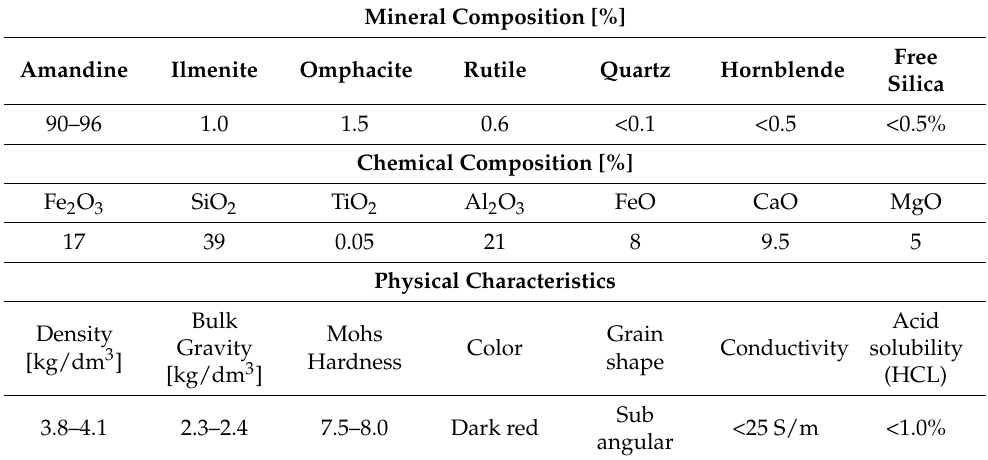
Table 1. Properties of J80A garnet